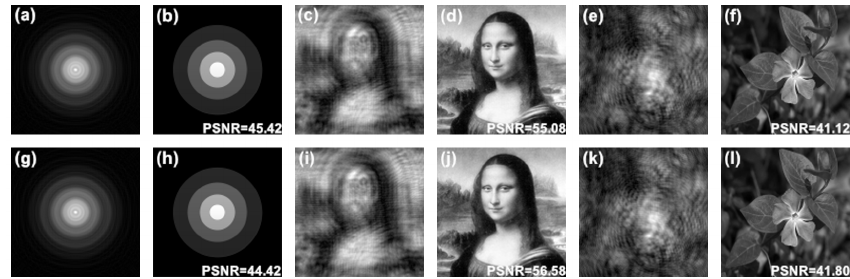
Figure 4. Verification of the proposed method. Panels ( a , c , e ) are diffracted field by PC method; panels ( b , d , f ) are reconstructed field by point source (PS) method; panels ( g , i , k ) are diffracted field by PS method; panels ( h , j , l ) are reconstructed field by PC